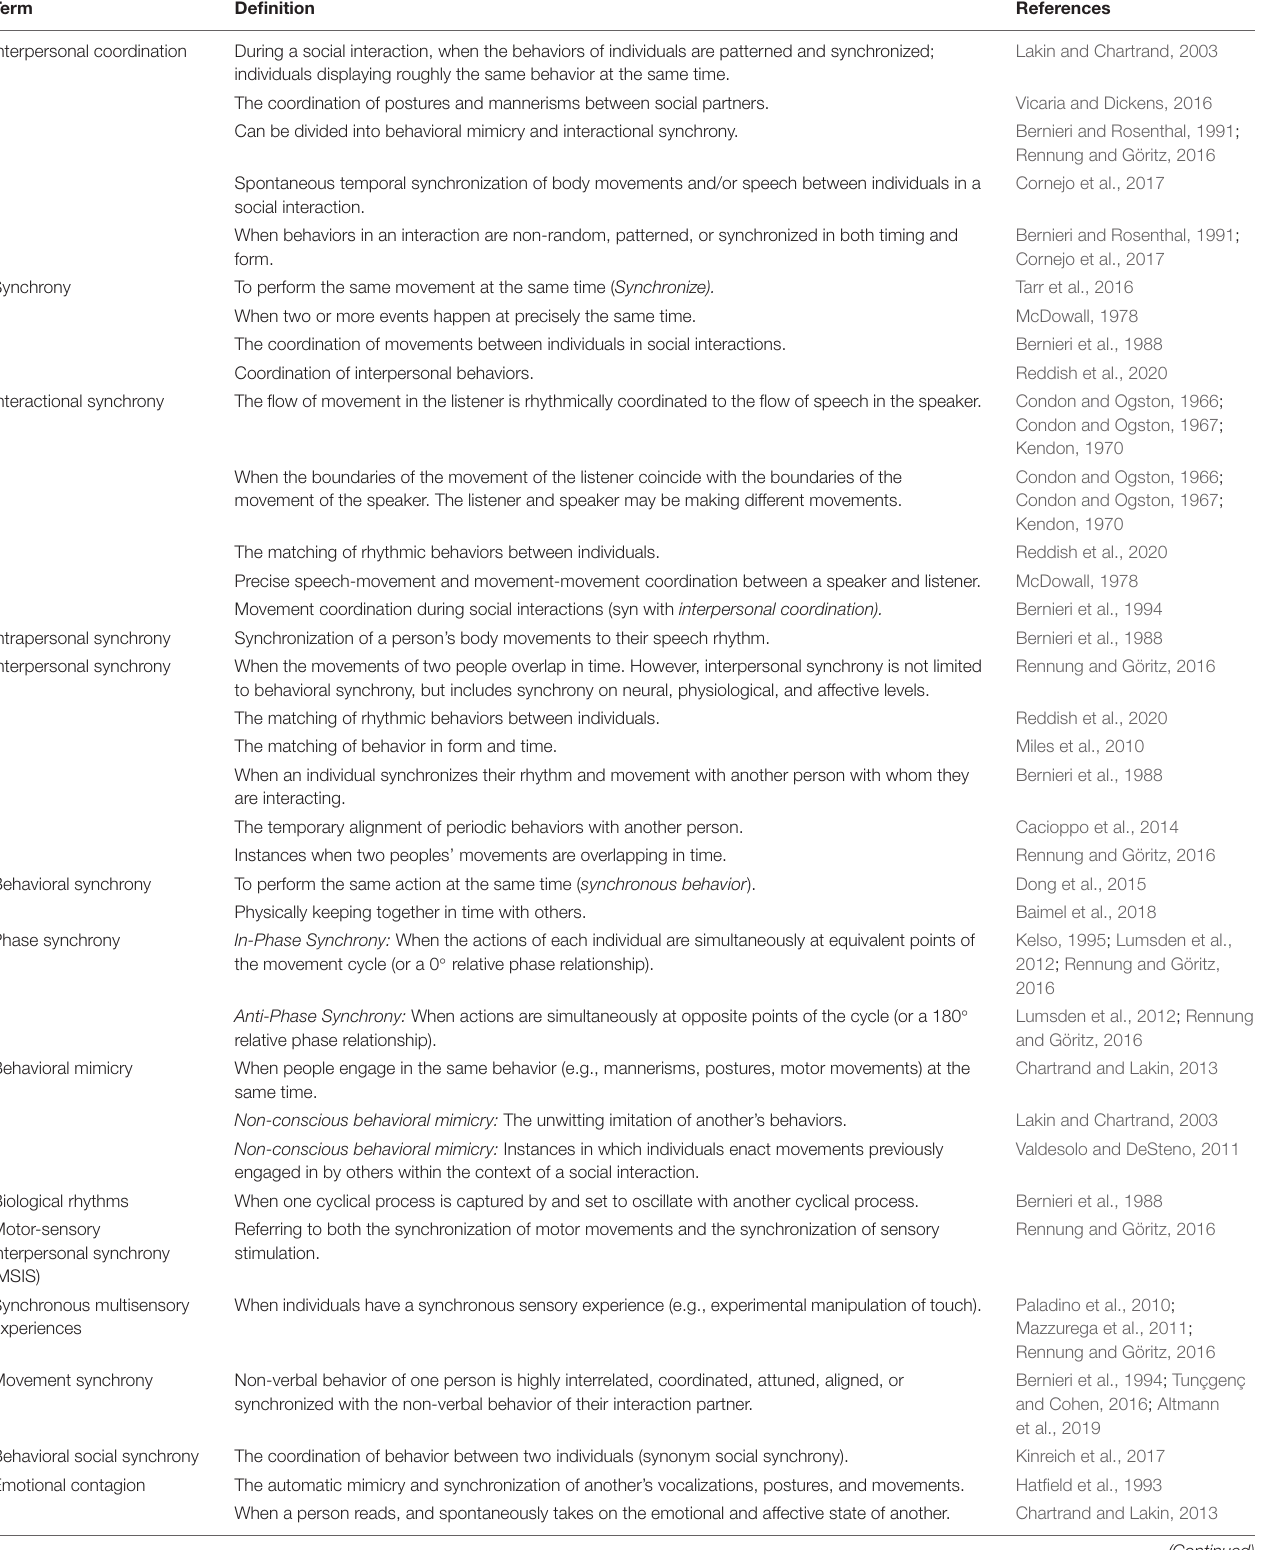
TABLE 1 | Definitions of terms used to describe behavioral synchrony/interpersonal coordination in